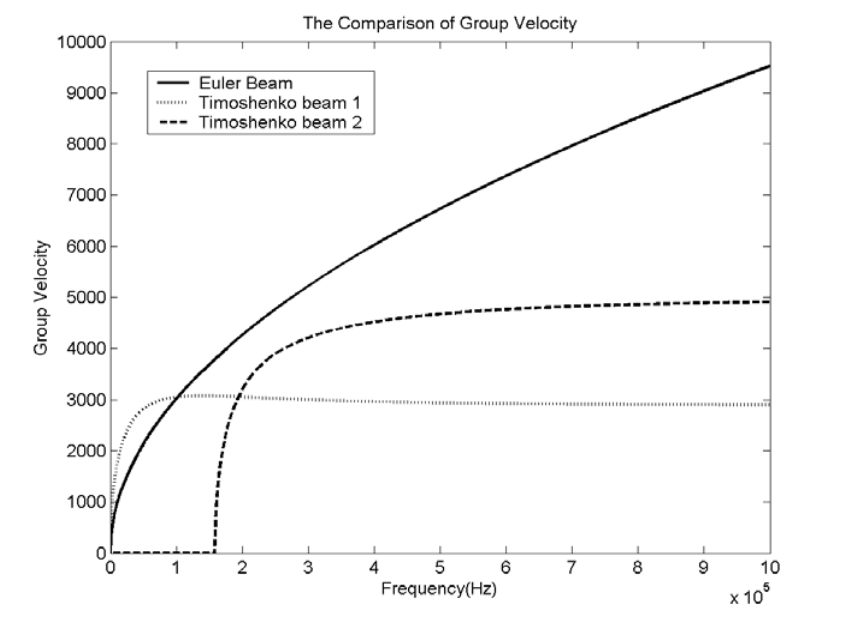
Fig. 2. The comparison of group velocities in the Euler-Bernoulli beam and the Timoshenko beam (steel, L × B × H = 1 m × 0.01 m × 0.01 m, f = 159 kHz). - · - · -, c ····· , c c g 1 of the Timoshenko beam; g 2 of the Timoshenko beam, —,